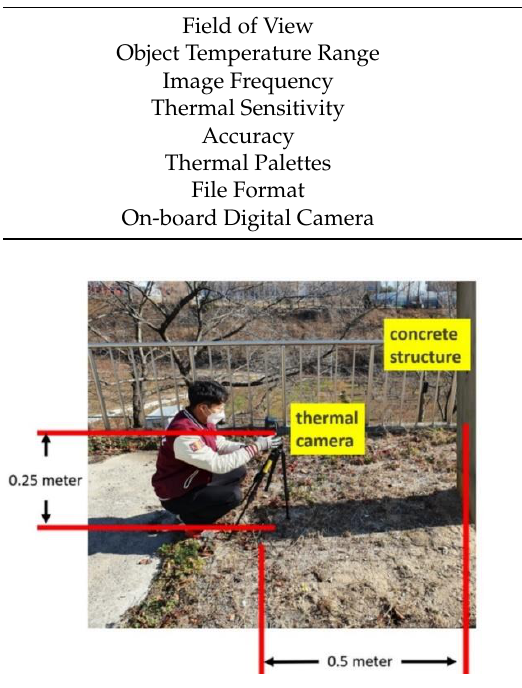
Figure 4. Physical setup for image